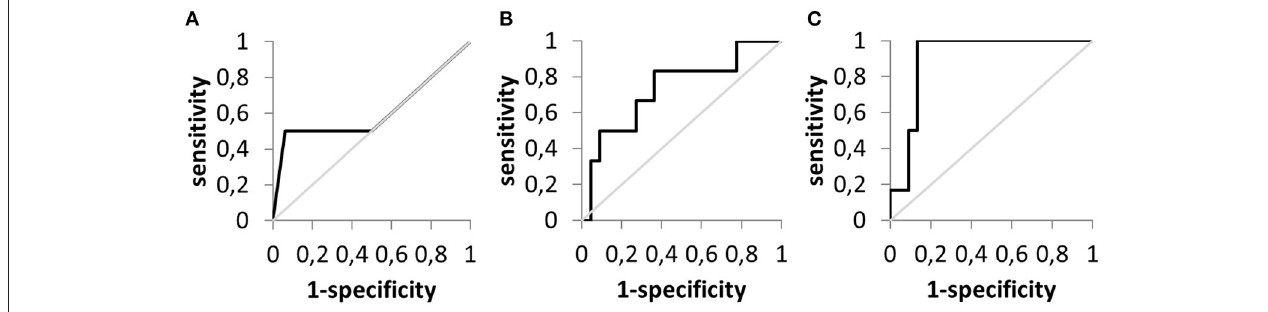
FIGURE 7 | Receiver operating characteristic curves to evaluate the prediction of feeding intolerance. (A) Aspirated gastric residual volume ( n = 20). (B) Calculated gastric residual volume ( n = 28). (C) Calculated nutrition formula transport ( n = 28).